Question: Describe this figure in one sentence.
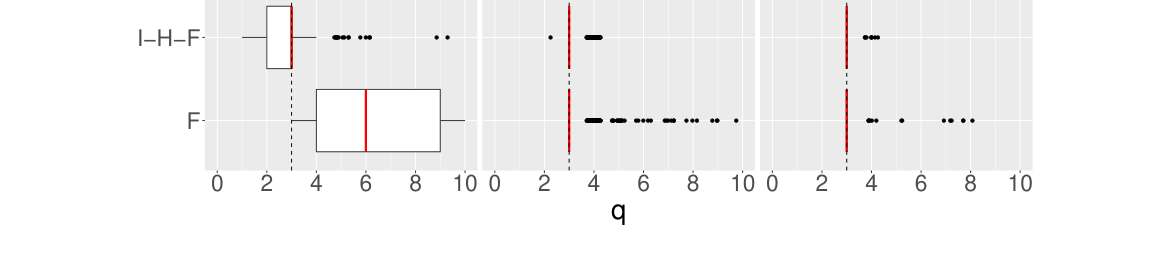
Answer: Simulation 1: boxplots for q (the number of hidden nodes selected) for each method by sample size. Median value highlighted in red. Dashed line indicates the true value of q.